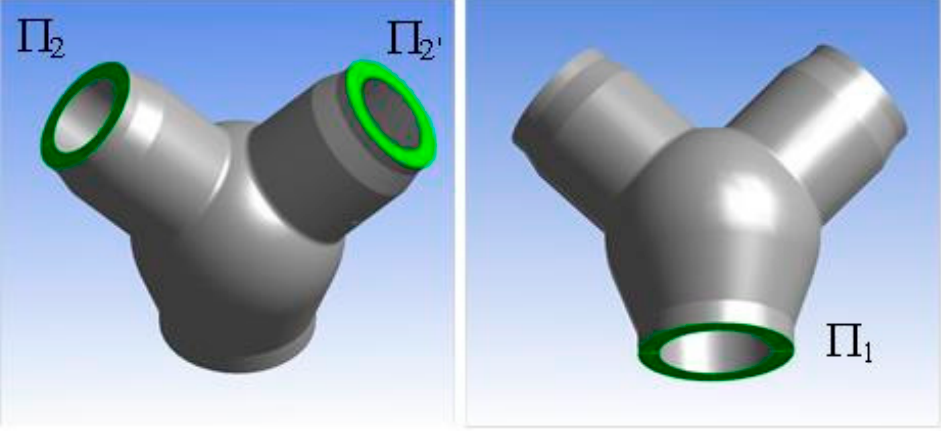
Figure 5. Model of the Y-shaped junction with plane sections for the extraction of the component from the entire pipeline.